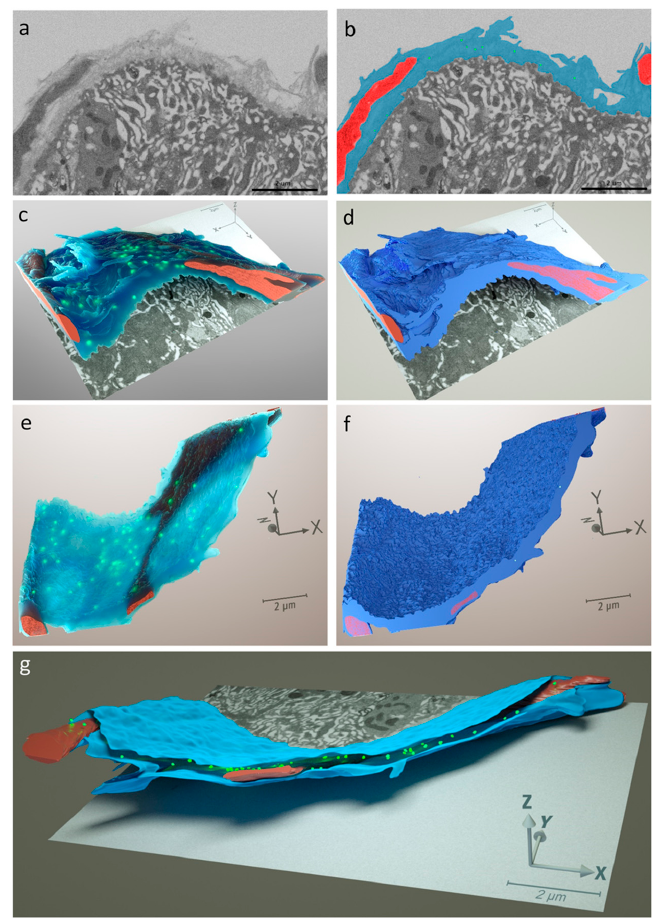
Figure 5. Three-dimensional (3-D) reconstruction from 108 stacked FIB-SEM-generated images serially sectioned at 20-nm intervals showing midgut tissue obtained from a CHIKV infected mosquito at 24